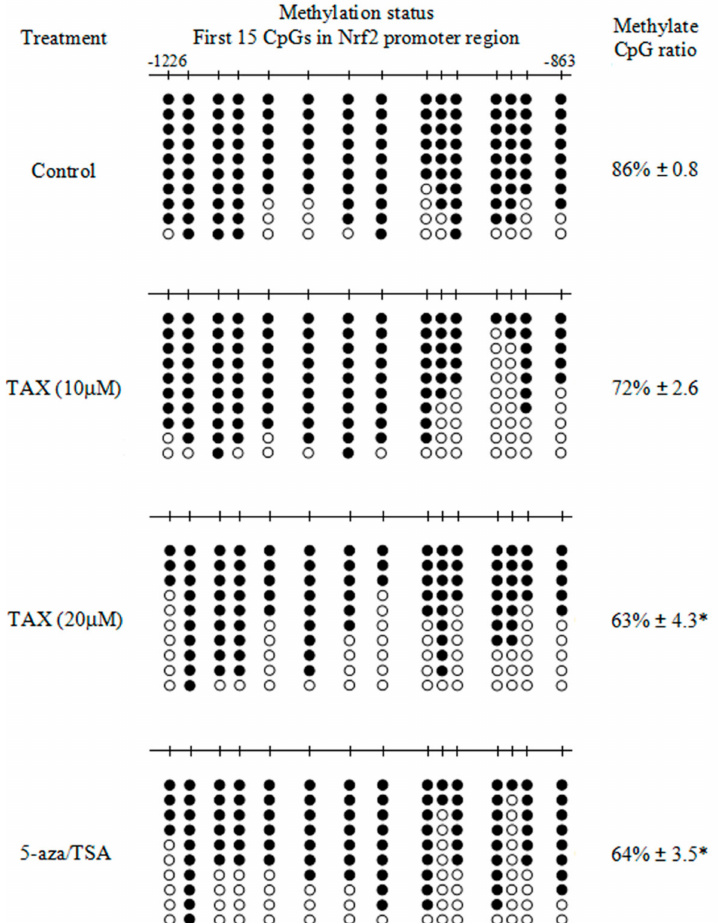
Figure 6. Methylation level at the 15 CpG sites (located between − 1226 and − 863) in the Nrf2 promoter determined by bisulfite genomic sequencing. The gene sequence of the first 15 CpG sites which located between − 1226 and − 863 was listed in the supplementary materials. The JB6 P+ cells were treated with different TAX concentration (10 to 20 µ M) or 5-aza (250 nM) in minimum essential medium (MEM) containing 1% fetal bovine serum (FBS) for 5 days. Trichostatin A (TSA) (50 nM) was added to the medium on day 4. TAX (10 and 20 µ M) and combination of 5-aza (250 nM)/TSA (50 nM) groups were compared with the DMSO control group. The comparison revealed significant differences (* p < 0.05) in methylation level. Black dots indicate methylated CpGs; open circles indicate the non-methylated CpGs. The 15 CpG sites correspond to the murine Nrf2 gene with the translational start site defined as +1. The values of the methylated CpG ratio are the mean ± SD of at least 10 clones from three independent